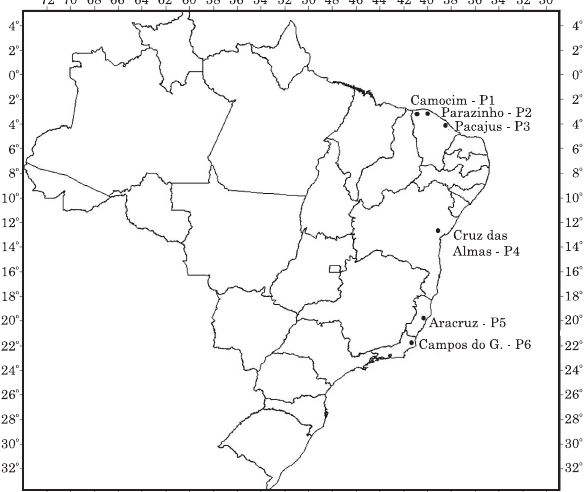
Figure 1. Location of the counties on the Coastal Tablelands in Brazil where the studied hard- setting soils were Table 1. Field descriptions of Brazilian hard-setting soils